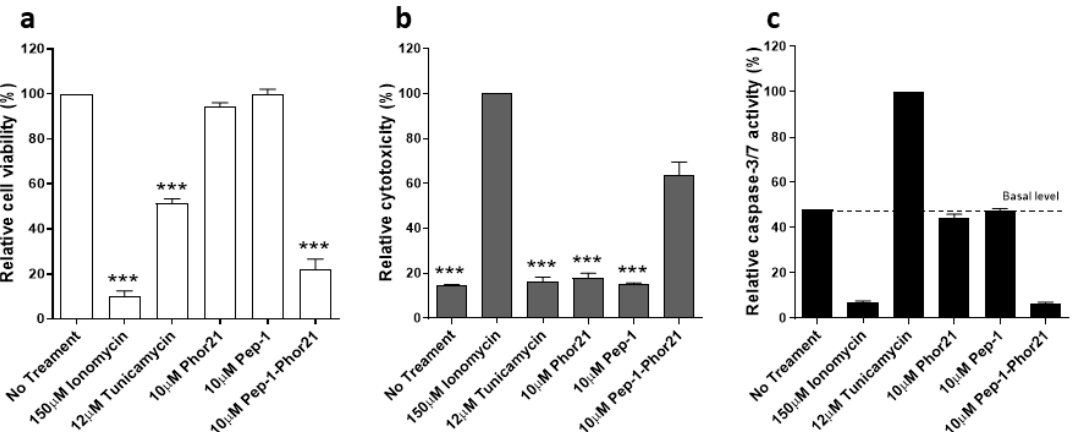
Figure 4. Characterisation of Pep-1-Phor21 mode of action. PC-3 cells were treated with Pep-1, Phor21, Tunicamycin (positive control for apoptosis), Ionomycin (positive control for necrosis (cytotoxicity)) or Pep-1-Phor21 for 6 h and cell viability ( a ), necrosis ( b ) and apoptosis ( c ) were assessed. Untreated ( a ), Ionomycin-treated ( b ) and Tunicamycin-treated cells ( c ) were considered to be 100%. The data represent means ± SEM (error bars represent SEM) of three independent experiments with three different passages of the respective cell line (*** p < 0.001).